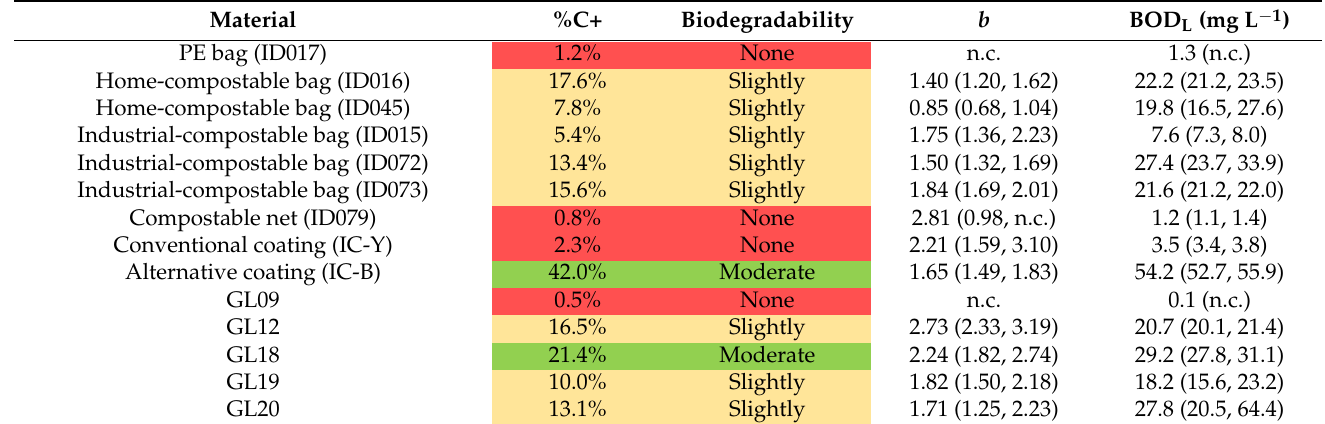
Table 2. Classification of the tested materials according to their marine biodegradability using the assessment criteria shown in Table 1, and fitting parameters using a non-linear logistic model (Equation (1) in the text). Ninety-five percent confidence intervals for the parameters are shown in parentheses. PE: polyethylene; n.c.: not